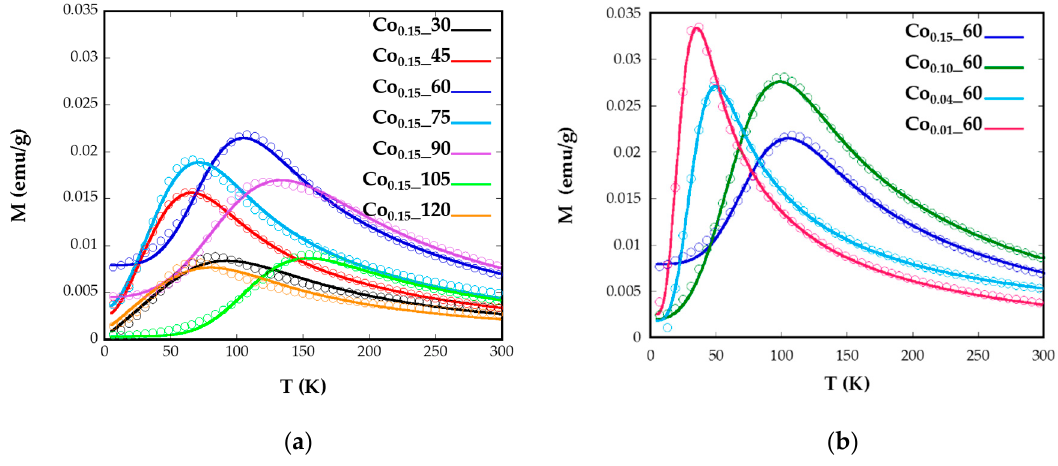
Figure 5. Experimental ZFC measurements (circular markers) with the fits (solid lines) using Equation (2) for samples Co x _ t for different ( a ) reflux times and ( b ) Co concentrations. Table 2. Formula obtained from ICP calculations, average blocking temperature (< T B >), apparent magnetic diameter ( D ZFC/FC ), anisotropy constant K eff , (0 K) calculated from Equation (2), magneto- crystalline anisotropy K c , calculated cobalt content (Co x ) from K c values, coercive field ( H c ) and magnetization saturation at 250 K ( M s ) for Co x _ t synthetized samples.